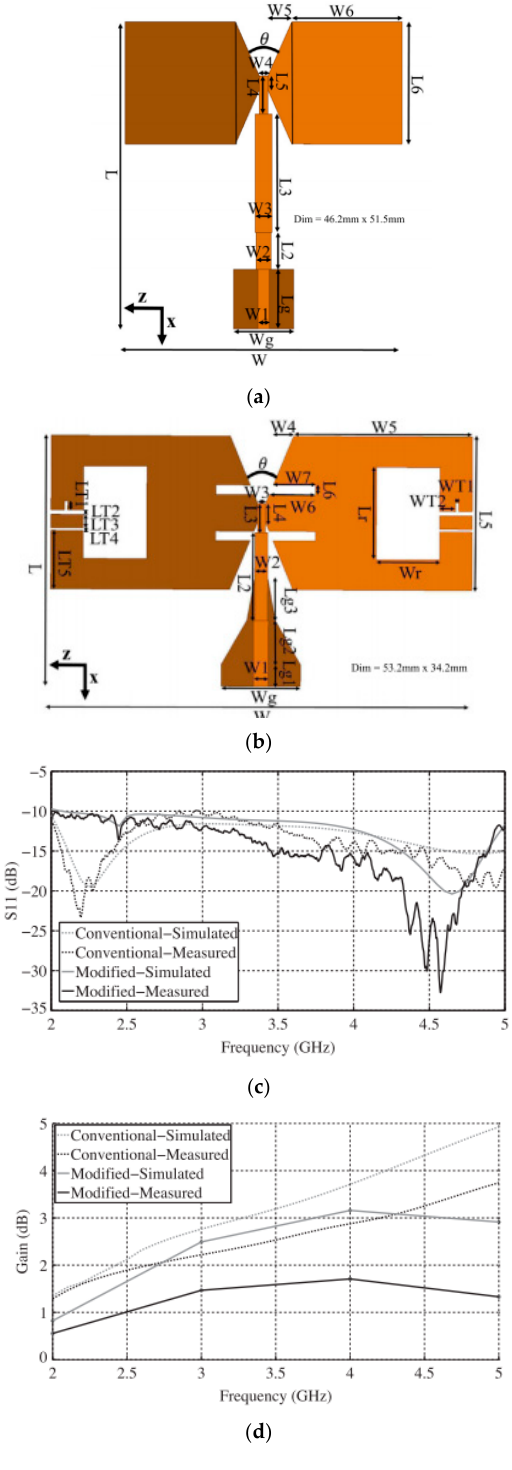
Figure 2. ( a ) Conventional antenna geometry; ( b ) Modified bow-tie antenna; ( c ) Simulated and measured return loss; ( d ) Simulated and measured gain. Reprinted with copyright permission from Ting et al. [107].